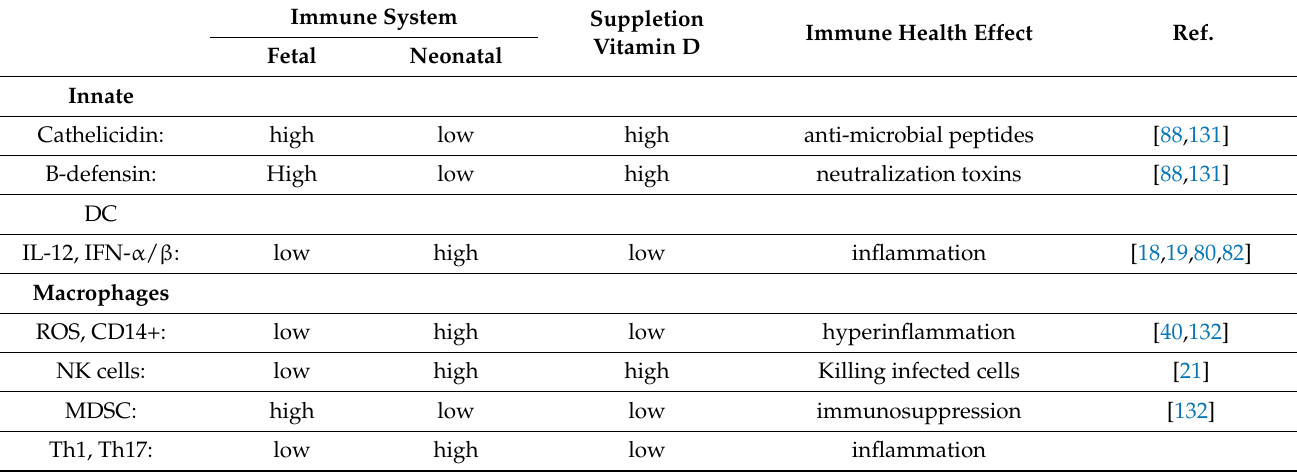
Table 1. Immune system characteristics in fetal and neonatal age and effects of vitamin D